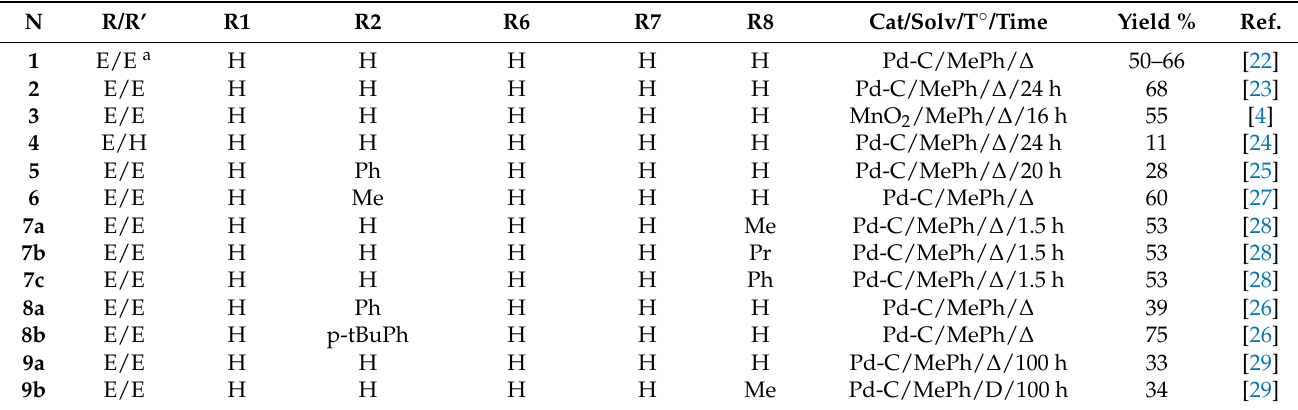
Table 1. Substituents, reaction conditions and yields of reactions of indolizines with substituted acetylenes giving cyclazines (Scheme